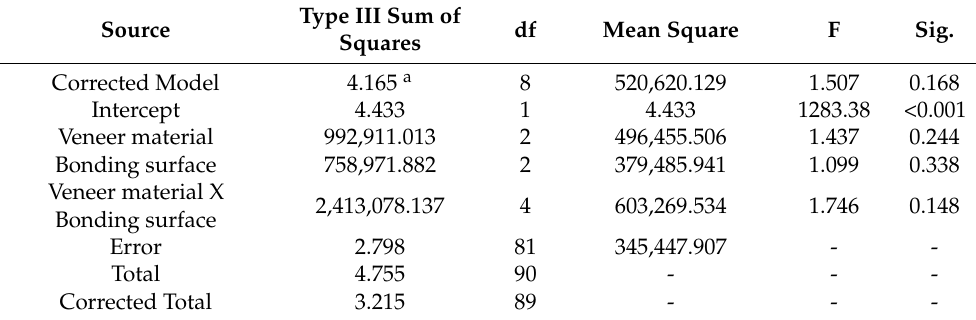
Table 4. Summary of two-way ANOVA test representing the interaction between the study variables.